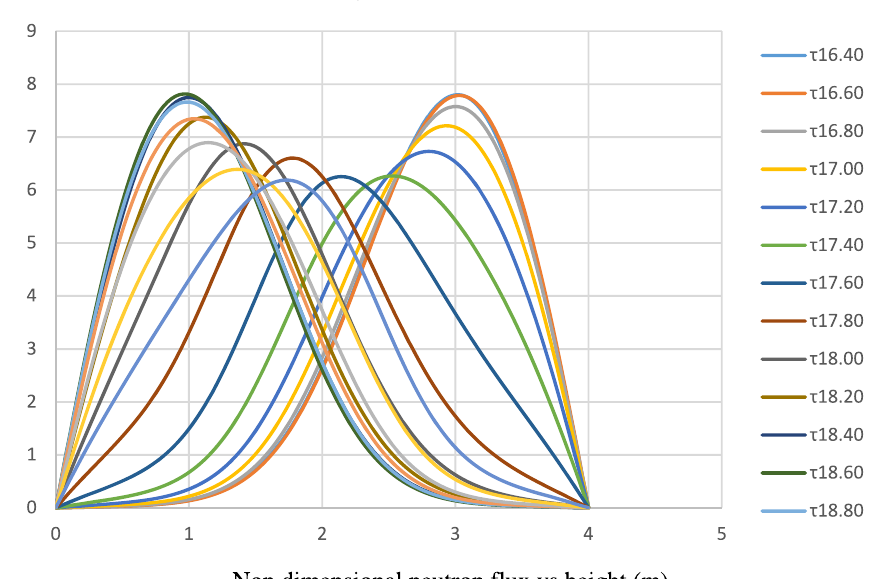
Fig. 1. The oscillation of neutron fl ux in 1 group model with M 2 = 64 cm 2 .